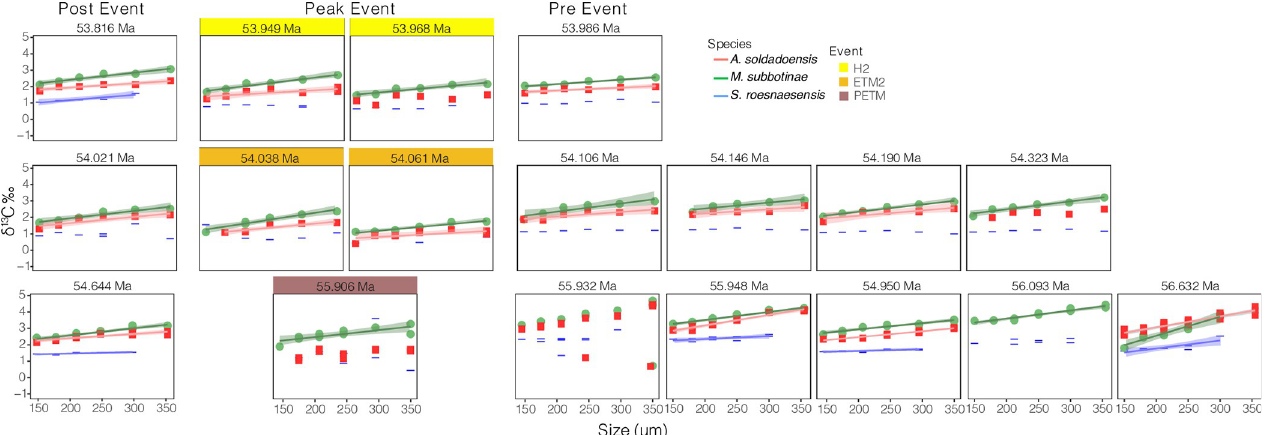
Fig 1. δ 13 C relative to size class for each interval analyzed. Intervals designated as ‘peak’ events are shaded in yellow, orange, and brown for the H2, ETM2, and PETM events. Intervals proceeding and following “peak” intervals represent those considered “pre” and “post” event samples, respectively. Significant (p- value < 0.05) linear fits are shown in each plot with a standard error envelope at the 95% confidence interval. PETM data is from